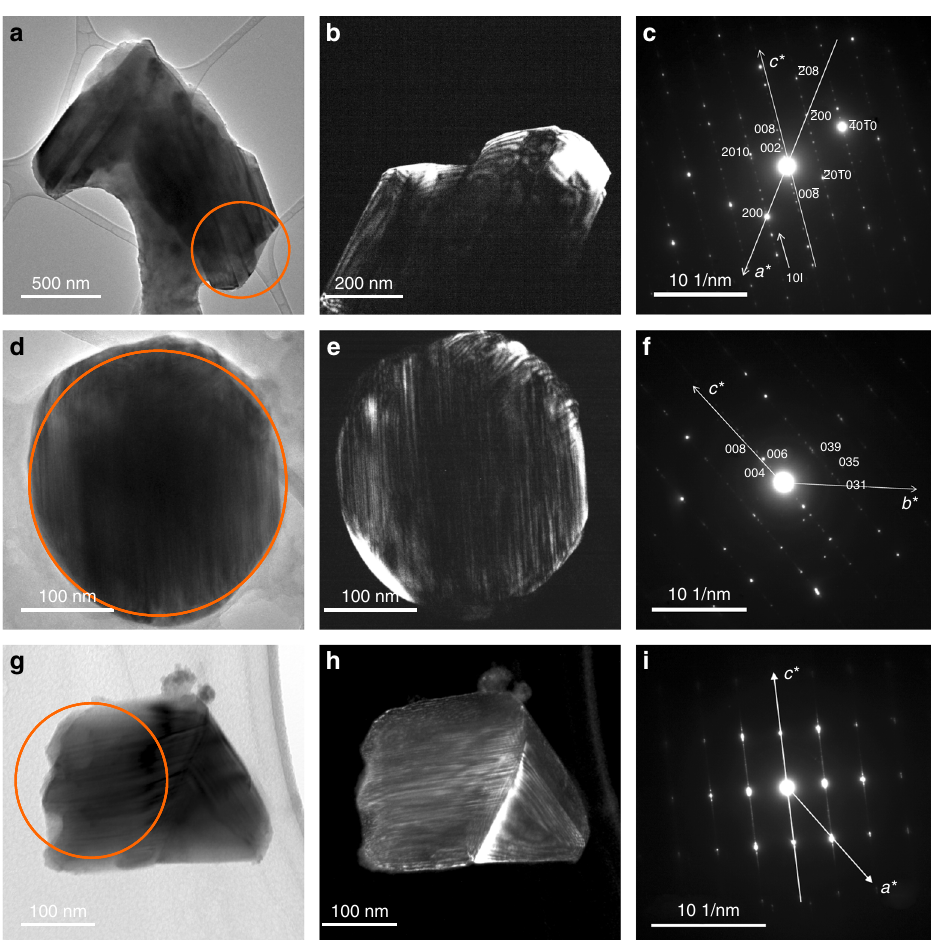
Fig. 3 Three examples of Magnéli phases of titania suboxides identi fi ed in coal ash from US and Chinese coals. a – c A Ti x O 2 x − 1 particle in bottom ash taken from a coal- fi red power plant I, Kentucky, USA, in 2001 (No. 9 in Table 1): a bright fi eld TEM image, b dark fi eld TEM image, and c SAED pattern of the Table 1): d bright fi eld TEM image, e dark fi eld TEM image, and f SAED pattern of the selected area in d , indicating a Ti 6 O 11 particle. g – i A Ti x O 2 x − 1 particle from fl y ash taken from a southwest Virginia, USA, coal- fi red power plant, USA, in 2014 (No. 3 in Table 1): g bright fi eld TEM image, h dark fi eld TEM image, and i SAED pattern of the selected area in g , indicating a Ti 8 O 15